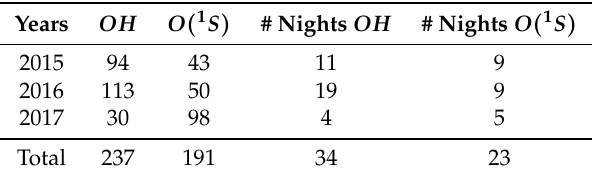
Table 5. Number of wave events for the OH and O ( 1 S ) emissions after applying the criteria in Table 4. These quantities represent the filtered image dataset for the cancellation factor (CF) computation taken during the observing runs presented in Tables 2 and